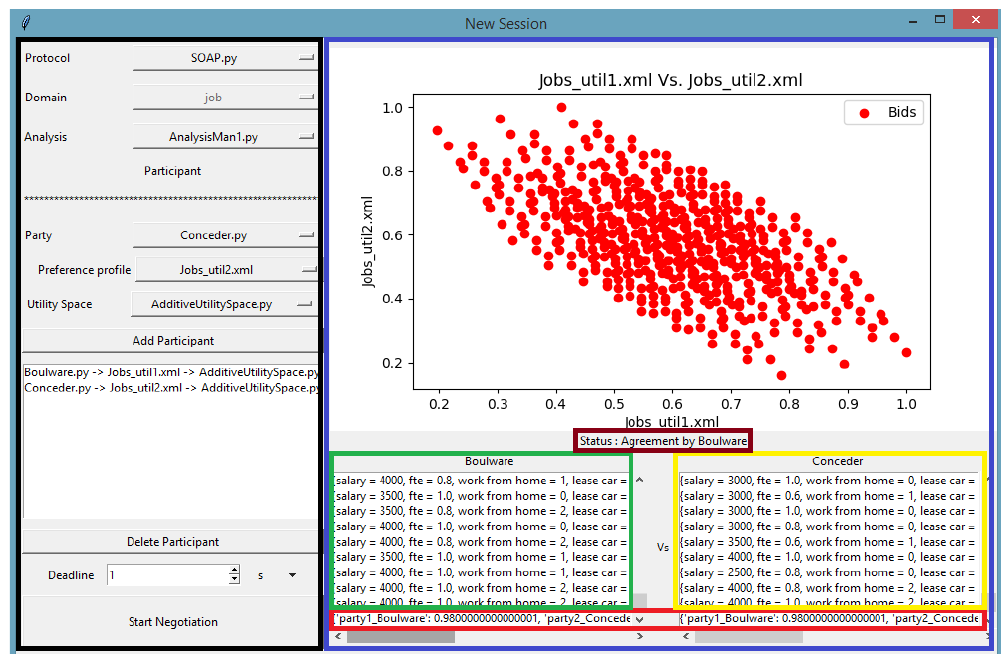
Figure 5. The negotiation session window has two major parts, shown in the inside of black and blue frames. The user sets the parameters in the inside of black frame, and the results are shown in the inside of blue frame after the session ends. This example shows the negotiation between Boulware and Conceder agents on the Job domain. AnalysisMan1 and SOAP were used as the analysis entity and the protocol, respectively. The user can see the result of the negotiation in the inside of brown frame. The offers of Boulware and offers of Conceder during the negotiation are shown in the inside of green and yellow frames, respectively. The analysis data produced by AnalysisMan1 are demonstrated in the inside of red frame.